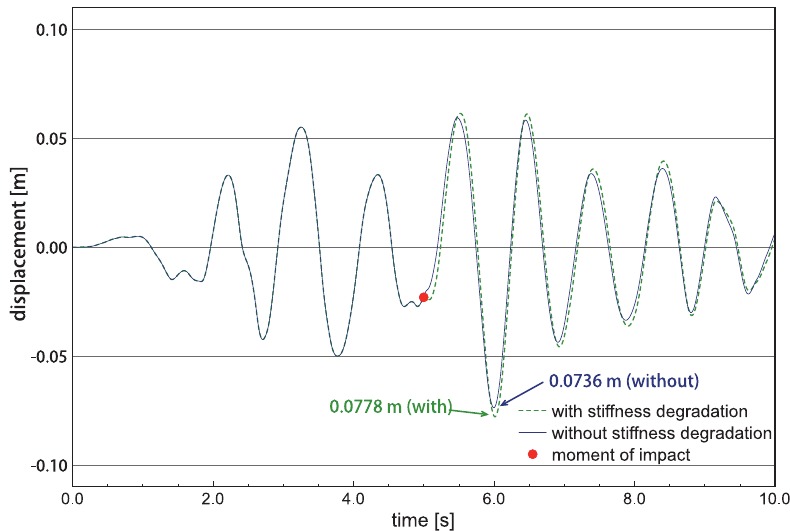
Fig. 9. Displacement time history of the first story of building under the El Centro earthquake with and without considering the degradation of horizontal stiffness for impact at t = 5